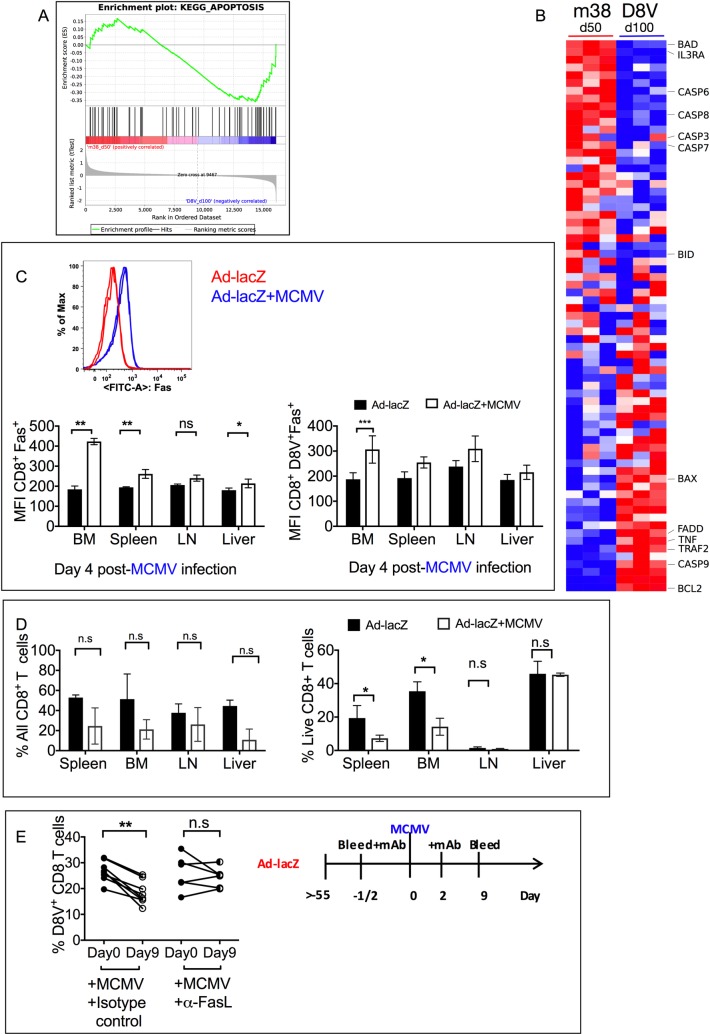
Analysis of death pathways after MCMV infection.(A) Microarray profiling of MCMV specific M38 CD8+ T cells and Ad-lacZ specific D8V CD8+ T cells was used for GSEA analysis for the KEGG apoptosis pathway comparing M38 inflationary cells at day 50 post infection to D8V inflationary cells at day 100 post infection. (B) Heatmap of the KEGG apoptosis pathway geneset from Fig 5A. Columns represent M38 or D8V samples and rows different upregulated (red) or downregulated (blue) genes. (C) A representative histogram of the levels of Fas on CD8 T cells isolated from bone marrow of Ad-lacZ only or Ad-lacZ-immune mice infected 4 days previously with MCMV. Levels of Fas on the surface of CD8 T cells (lower left) and D8V+CD8 T cells (lower right) isolated from the indicated organs at 4 days post-MCMV infection. (N = 4–5 per group from two independent experiments). (D) Single cell suspensions prepared from organs of mice at 4 days post-MCMV infection were cultured in vitro in complete RPMI for 2 days. The samples were gated on total CD8 T cells and the percentage of live CD8 T cells (left) and the percentage of D8V+ tetramer positive cells (right) within the live CD8 T cell population in each organ is shown. The data are from 4–5 mice per group from two independent experiments). (E) Mice were immunized with Ad-lacZ, then left for more than 55 days. One group of mice were injected i.v. with 100μg anti-FasL or isotype control antibody per mouse either one day before or on the same day as infection with 1x106pfu MCMV. A second antibody treatment was performed 3 days post-MCMV. Blood was collected 9 days later and the levels of D8V+ CD8+T cells measured. Data from two independent experiments are shown. Each datapoint represents an individual mouse. p values determined by T-tests **p<0.005.